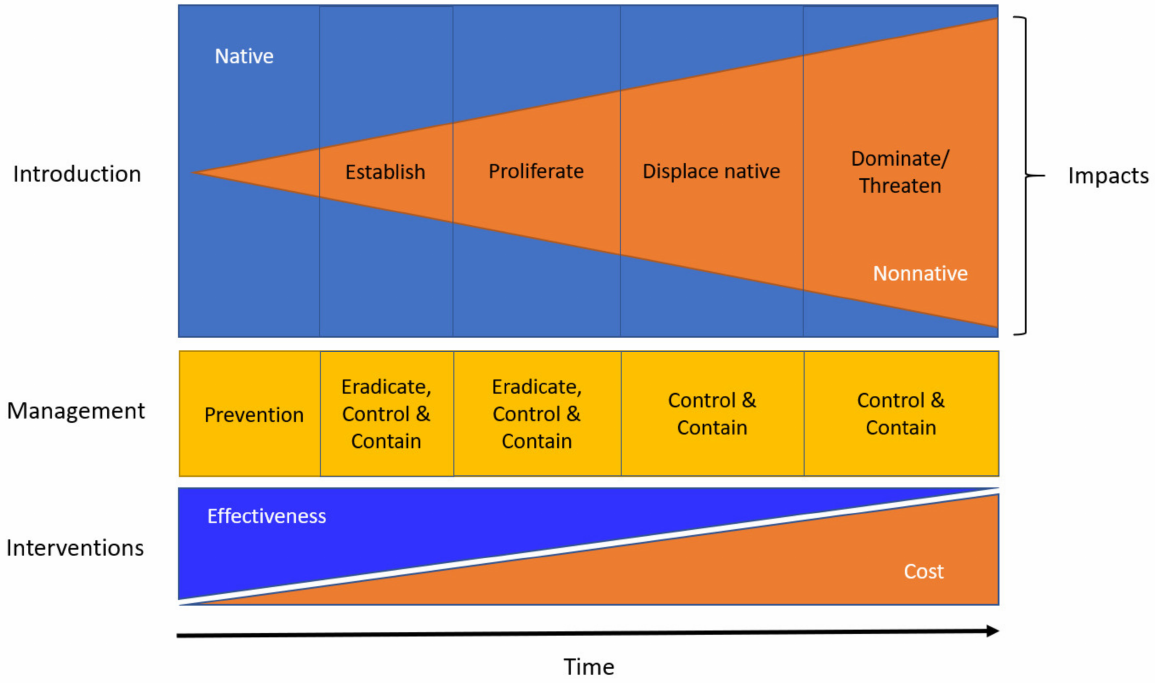
Figure 1. Management and cost/benefit of interventions as an invasive species impacts a new ecosystem starting with species